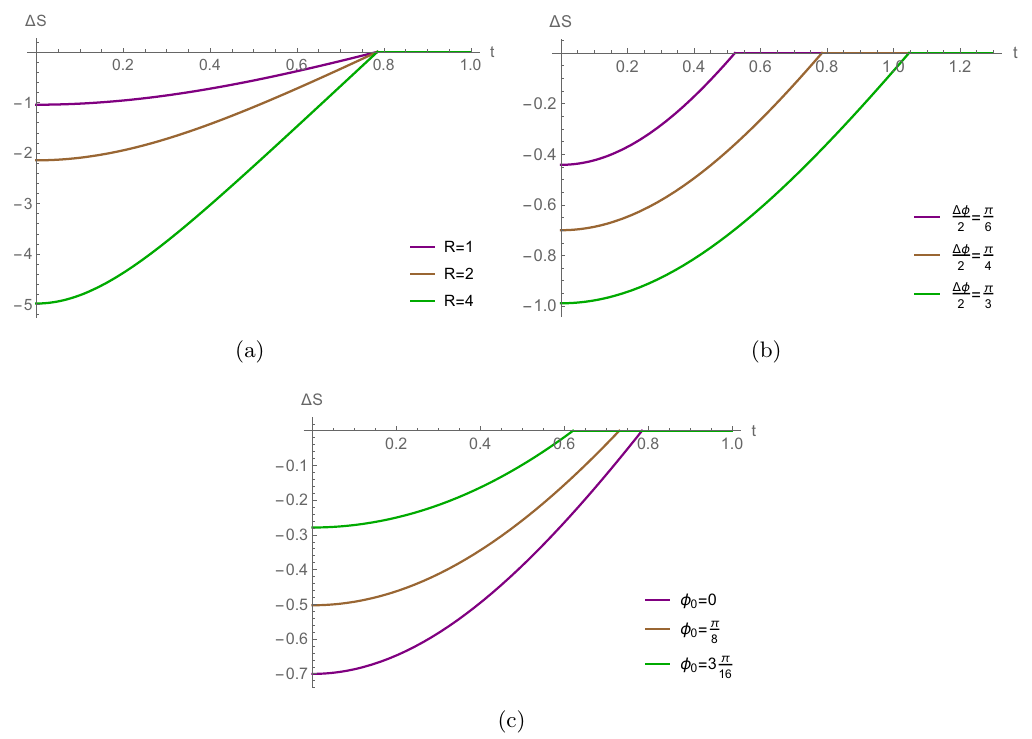
Figure 16 . (a) time dependence of HEE for di(cid:11)erent values of horizon radius. The parameters of the subsystem are ’ 0 = (cid:0) (cid:25) , (cid:1) ’ = (cid:25) . (b) time dependence of HEE for subsystems of di(cid:11)erent size. 4 2 Here ’ 0 = 0 and R = 0 : 5. (c) time dependence of HEE for di(cid:11)erent positions of the subsystem. Here (cid:1) ’ = (cid:25) and R = 0 : 2